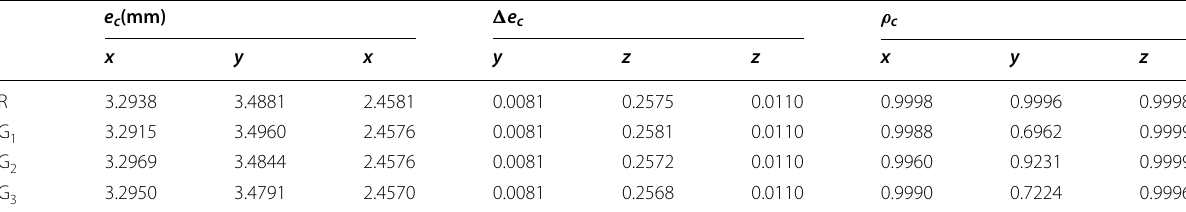
Table 3 Reachability and similarity of the generalized positions